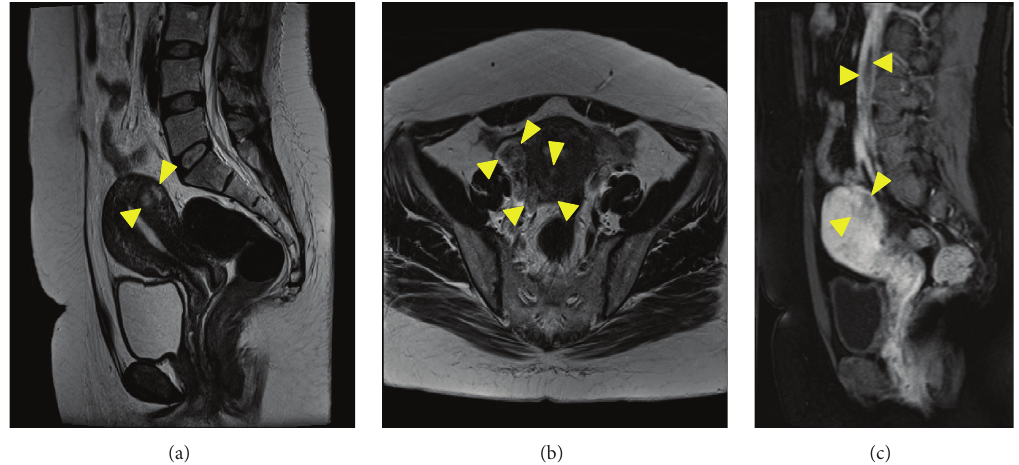
Figure 2: Magnetic resonance imaging (MRI): (a) on T2 weighted image, an irregular tumor is identified in the right posterior wall of the uterus, which exhibited heterogeneous high signal intensity (arrowheads); (b) the right uterine vein and ovarian vein are dilated, and low and high intensity masses are depicted in the veins and originated from the high intensity tumor in the posterior uterine wall (arrowheads); (c) sagittal view of dynamic contrast-enhanced MRI demonstrates large filling defect in the inferior vena cava with gradually increasing enhancement (upper arrowheads) and poor enhancement of tumor in the posterior uterine wall (lower arrowheads).